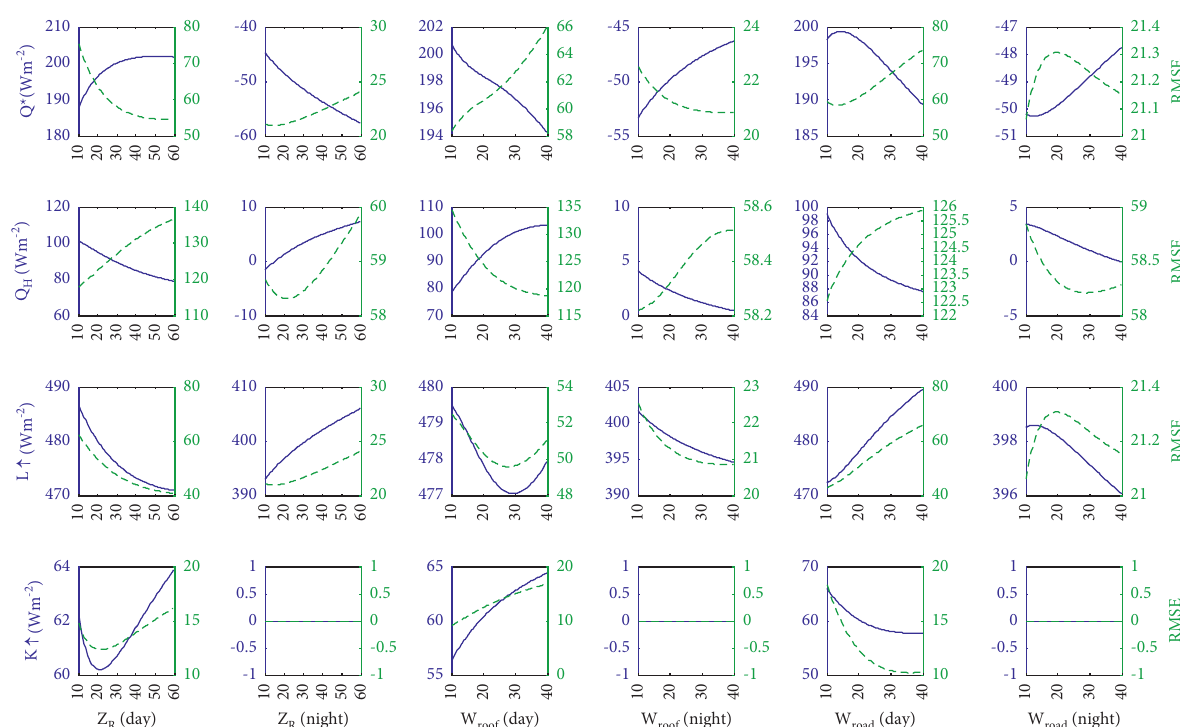
Figure 11: The same as Figure 7, but for morphological